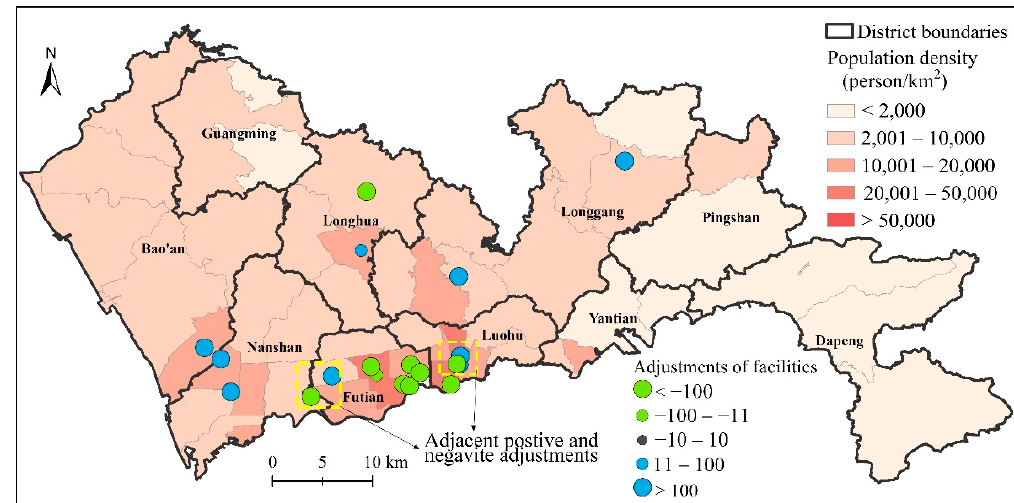
Figure 5. Size adjustments of existing tertiary healthcare facilities according to optimization.